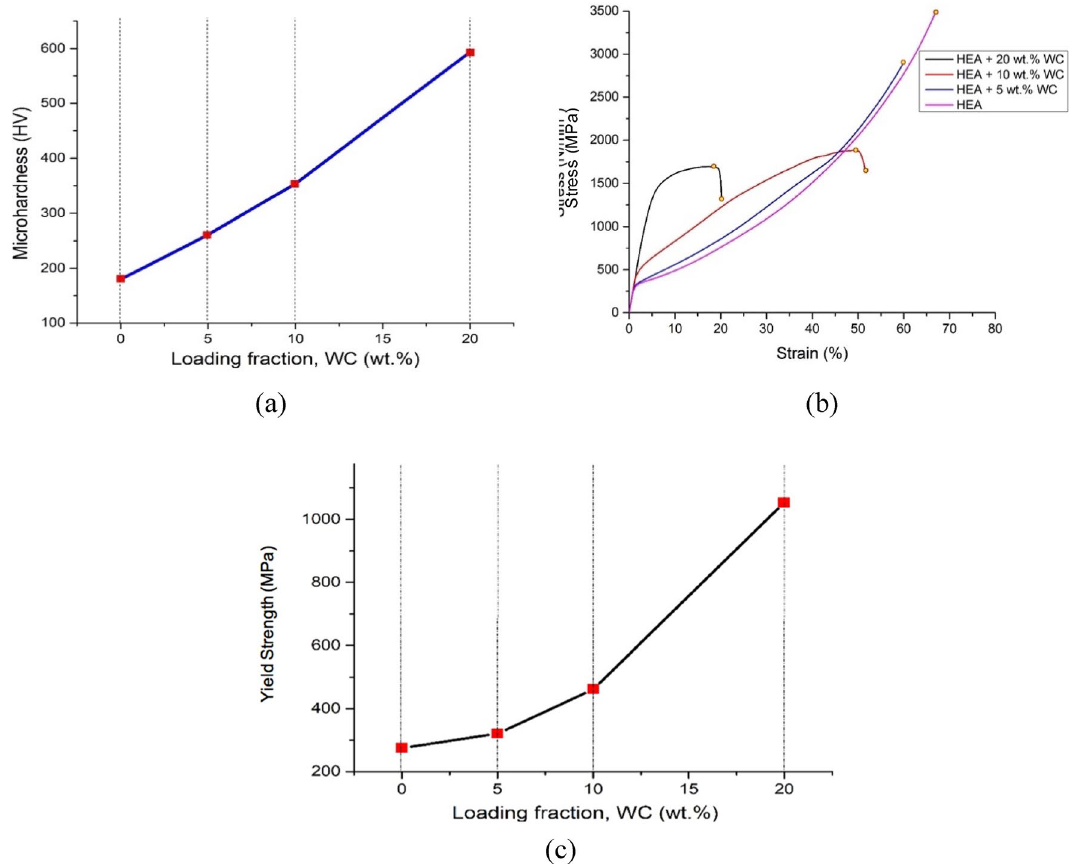
Figure 5. Mechanical properties of the HEA–WC composites: ( a ) variation of hardness as a function of amount of added WC (loading fraction); ( b ) compressive stress–strain curves; and ( c ) variation of yield strength (0.2% proof stress) as a function of amount of added